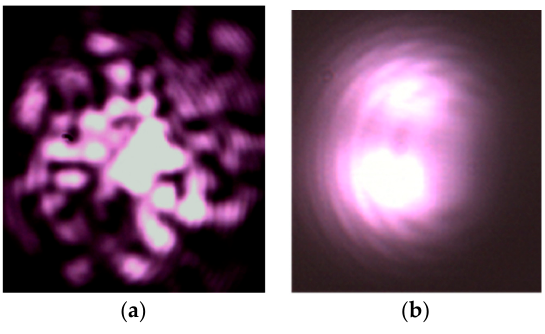
Figure 1. Example of the multi-mode interference pattern ( a ); and the few-mode interference pattern ( b ).